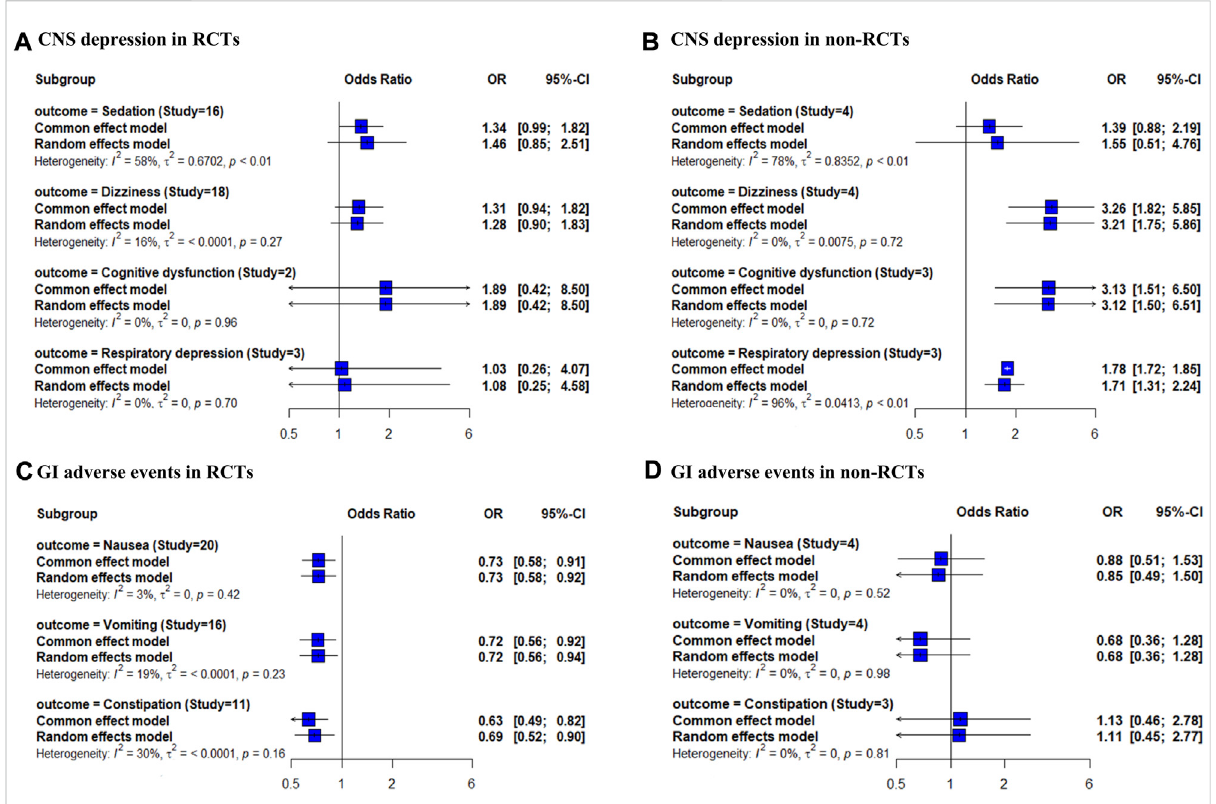
FIGURE 1 Forest plot of the risk of CNS depression and GI adverse events in opioid and gabapentinoid combination therapy compared with opioid therapy. (A) CNS depression in RCTs, (B) CNS depression in non-RCTs, (C) GI adverse events in RCTs, and (D) GI adverse events in non-RCTs. CNS, central nervous system; GI, gastrointestinal; RCTs, randomized controlled